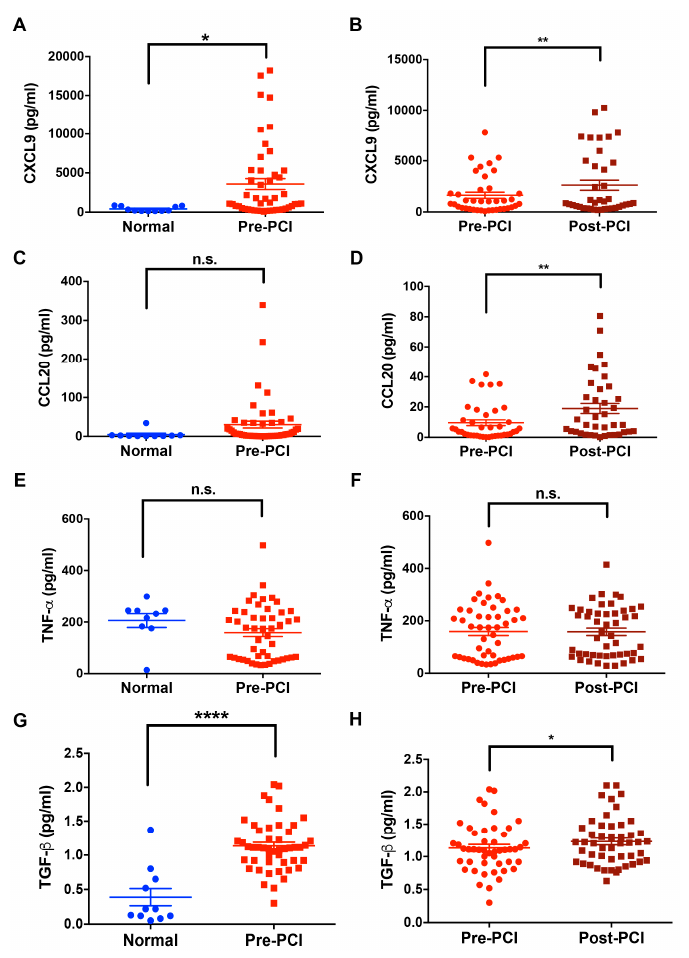
Figure 2. Expression of CXCL9 and CCL20 before (pre-PCI) and 3 h after coronary reperfusion by PCI (post-PCI) in patients with MI ( n = 39–50) compared to normal controls (healthy volunteers in our laboratory) ( n = 11). CXCL9 and CCL20 were measured by ELISA. ( A ) Expression of CXCL9 in normal controls and patients with MI. ( B ) Serum CXCL9 levels post-PCI in patients with MI remained more elevated than pre-PCI. ( C ) Serum CCL20 levels in normal controls and patients with MI. ( D ) Serum CCL20 levels change significantly after PCI. ( E ) Serum TNF- α levels in normal controls and patients with MI. ( F ) Serum TNF- α levels did not change significantly after PCI; ( G ) Serum TGF- β levels in normal controls and patients with MI. ( H ) Serum TGF- β levels in post-PCI MI patients remained more elevated than pre-PCI. ELISA = enzyme-linked immunosorbent assay; MI = myocardial infarction; TGF- β = transforming growth factor- β ; TNF- α = tumor necrosis factor- α ; PCI = percutaneous coronary intervention. Results are presented as mean ±